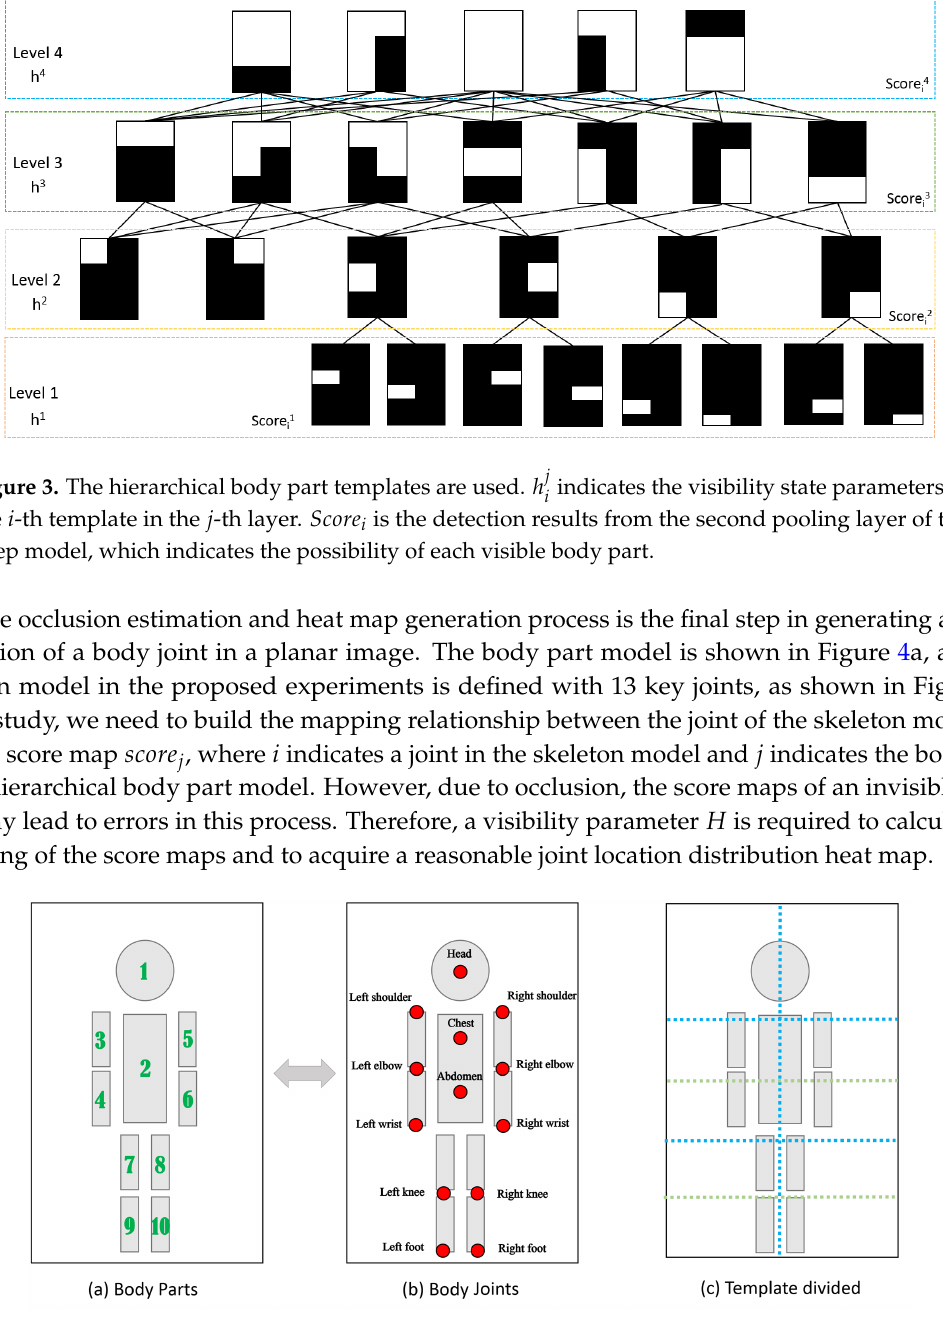
Figure 4. The body structure used in our experiment. ( a ) The fundamental body part structure; ( b ) the joints of the model that need to be estimated and reconstructed in planar and spatial space; ( c ) a division for body parts, which guides the layering of the occlusion